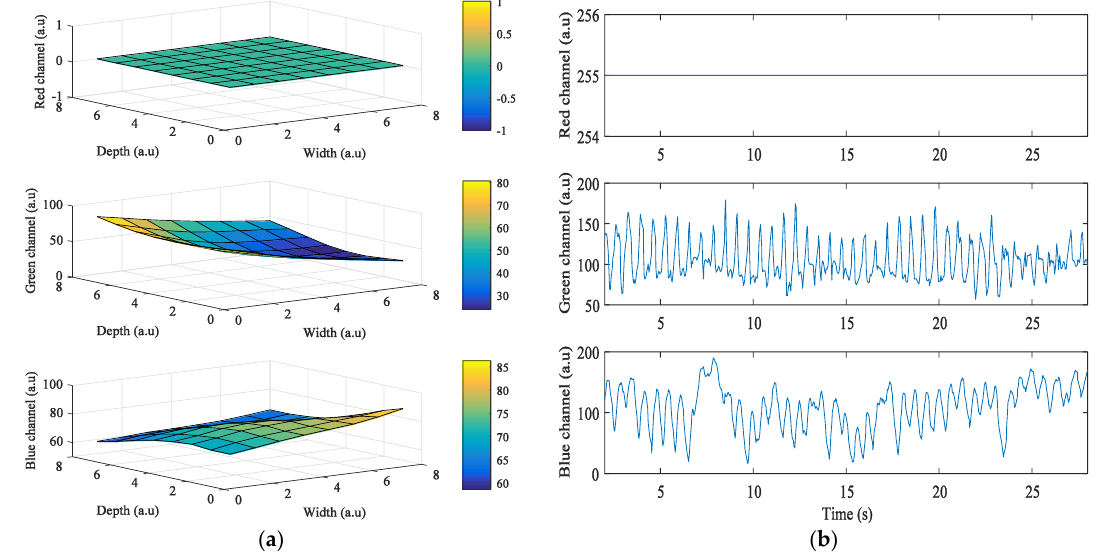
Figure 7. Example of quality analysis of PPG signals obtained from a subject using the Galaxy S6 with vertical movements: ( a ) intensity change distribution; ( b ) intensity of PPG signal.